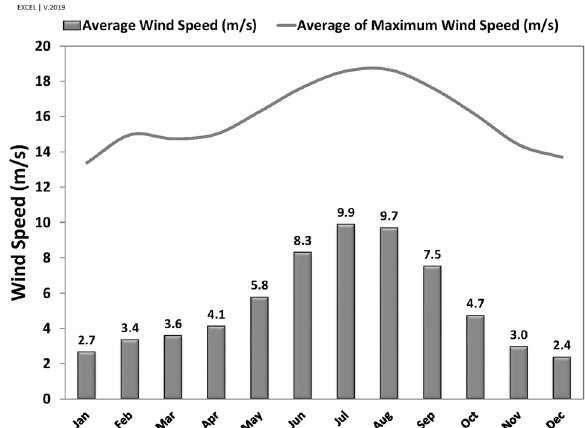
Figure 3. Average and Average of maximum wind speed (1963–2020).